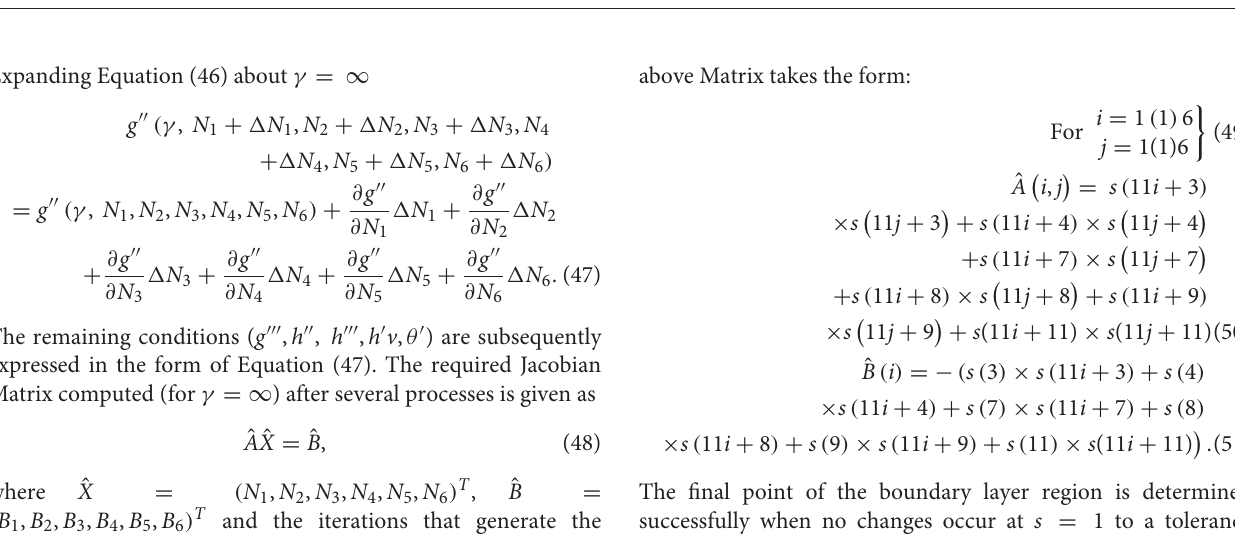
FIGURE 4 | (A) Effects of Pr on temperature field θ(γ) . (B) Effects of Ec ′ , Ec on temperature field θ(γ) . (C) Effects of Rd on temperature field θ(γ) . (D) Effects of n on temperature field θ(γ) . (E) Effects of w on temperature field θ(γ) . (F) Effects of Ha on temperature field θ(γ) .